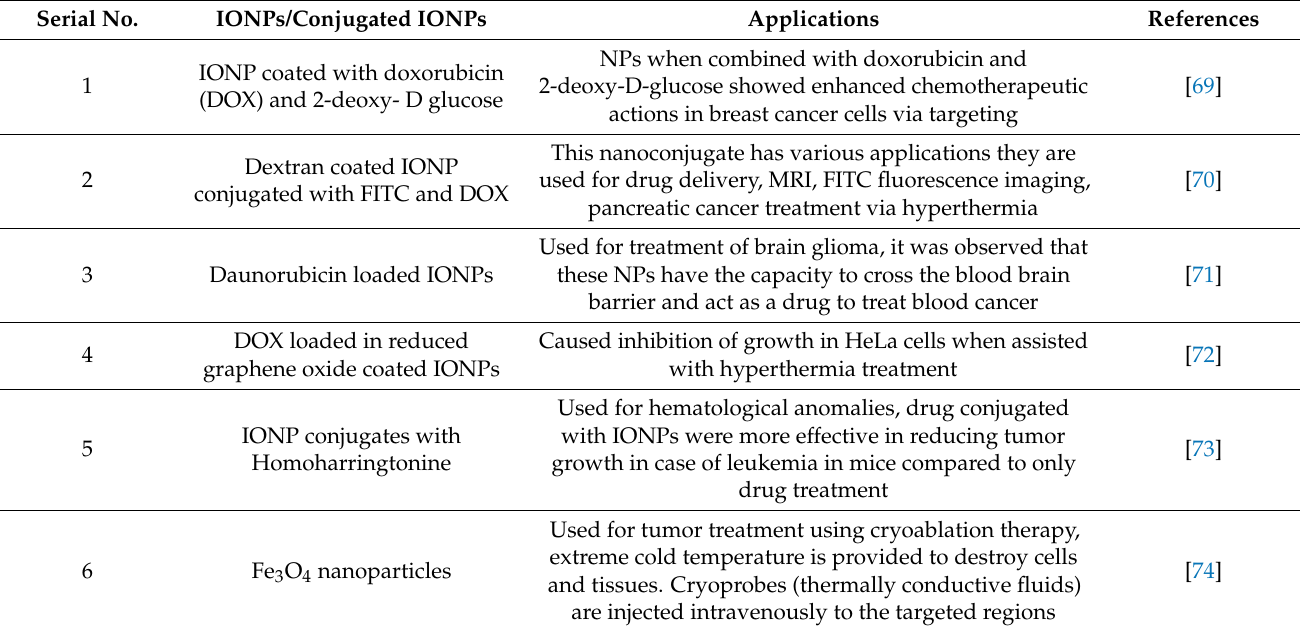
Table 3. List of various iron oxide nanoparticles/chemically modified iron oxide nanoparticles used for loading anticancer drugs and gene for targeted delivery. Serial